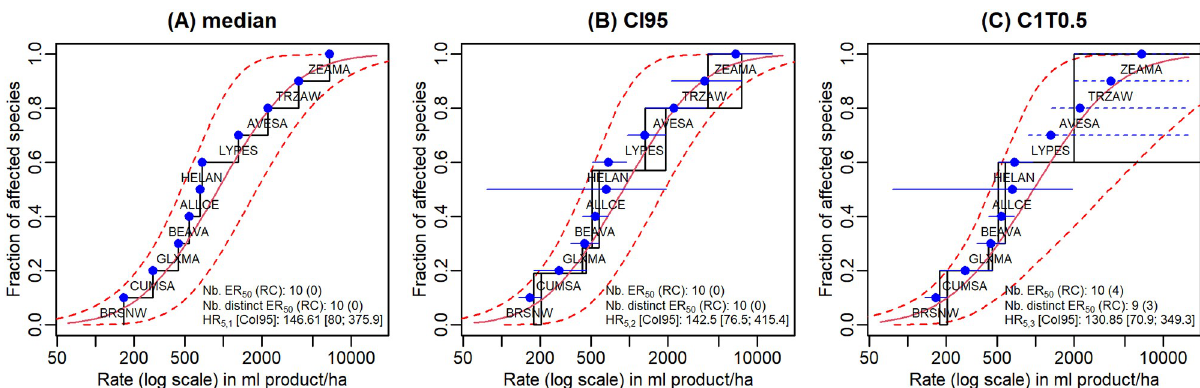
Fig 4. Example of three SSD analyses based respectively on ER 50 medians, CI 95 of ER 50 and censored ER 50 according to C1T0.5 for the shoot dry weight endpoint of the VV test from case study 1. Blue points represent fractions of affected species (EPPO code) ordered by the median of their ER 50 . Solid blue horizontal segments stand for interval-censored ER 50 by their CI 95 and dotted ones stand for right-censored ER 50 . Solid red curves represent fitted SSD curves and dotted ones represent 95% confidence interval ( CoI 95) of the fitted SSD curves. Meaning of legends: Nb. ER 50 (RC) stands for the number of ER 50 (the number of right-censored ER 50 ); Nb. distinct ER 50 (RC) stands for the number of distinct ER 50 (the number of distinct right- censored ER 50 ); HR 5 [ CoI 95] stands for the estimated HR 5 with its CoI